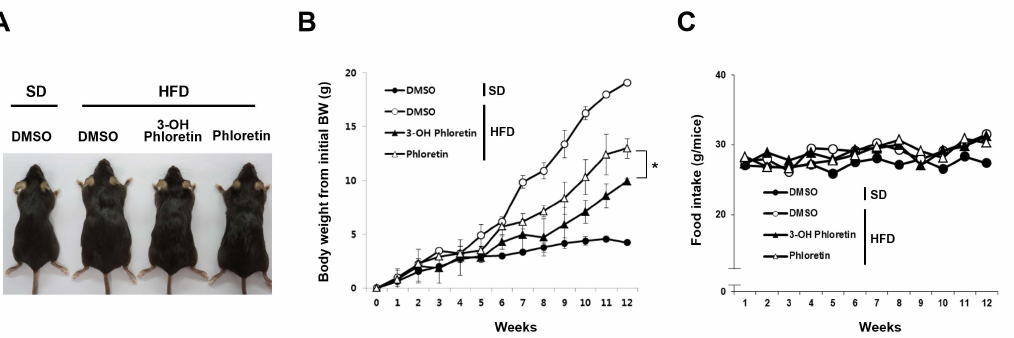
Figure 1. 3-OH phloretin decreased HFD-induced body weight gain more than phloretin. Changes in body size ( A ), body weight ( B ), and food intake ( C ) by administration of 3-OH phloretin and phloretin in WT mice fed SD or HFD for 12 weeks ( n = 5/each group). 0.5% DMSO was used to solubilize 3-OH phloretin, and phloretin was administered as a control. Data are shown as the mean ± standard error of the mean (SEM) from eight independent experiments with similar results (* p < 0.05).